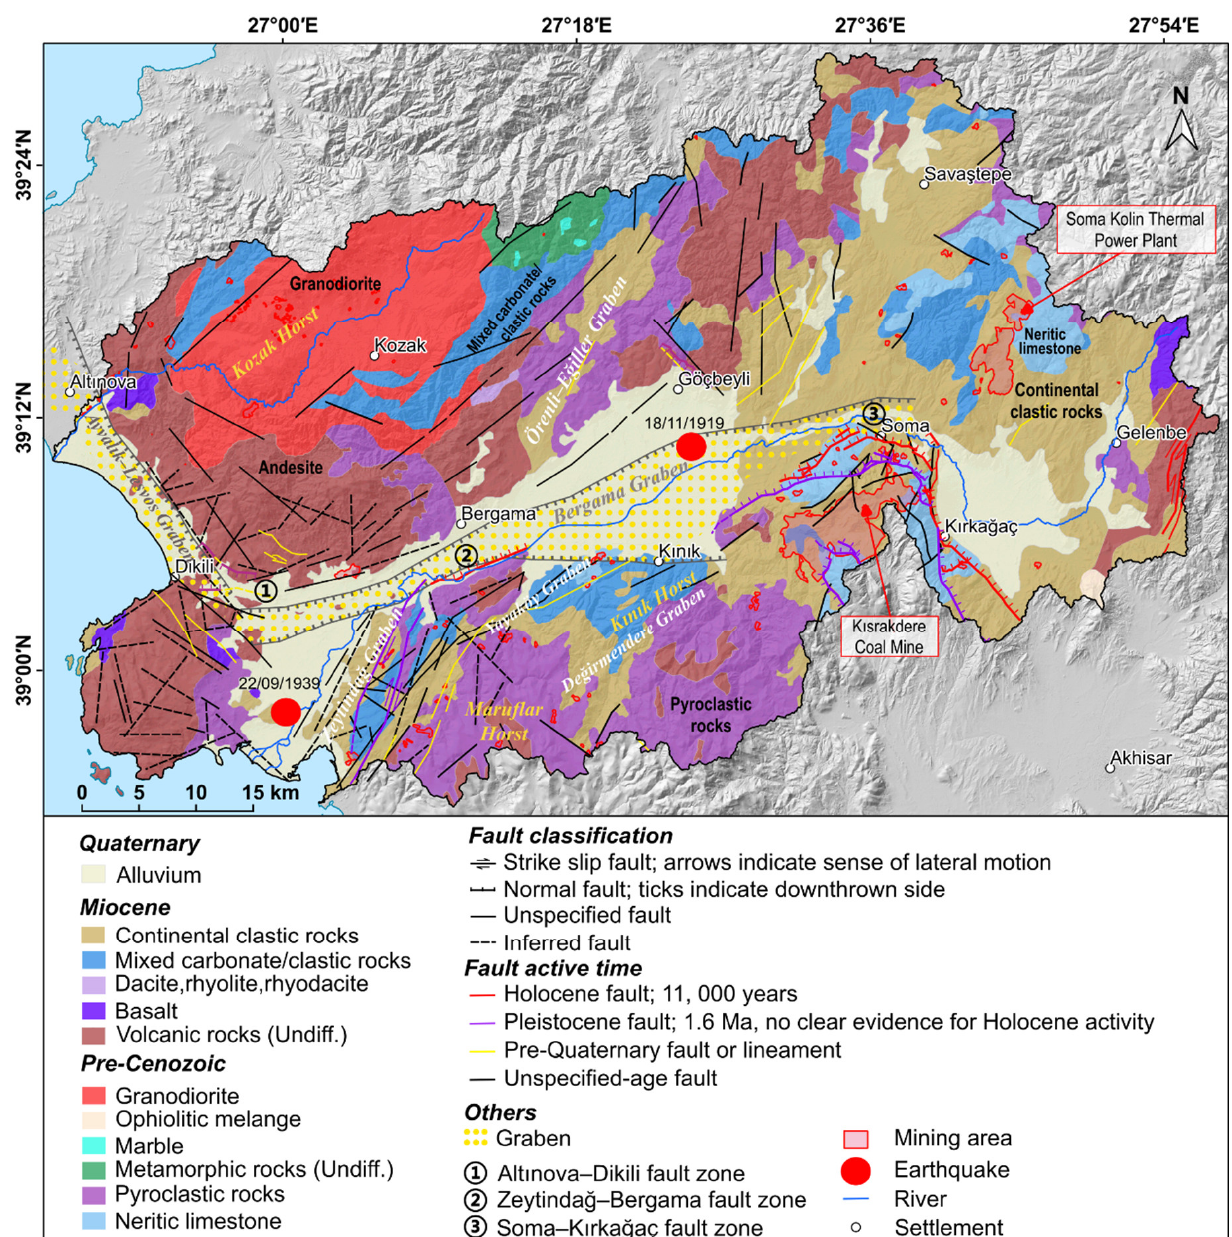
Figure 2. Geological map of the Bakırçay and Madra River catchments and their adjacent coastal areas. Data: (1) bedrock: Geological Map of Turkey, 1:500,000 (İzmir) [60]; (2) fault: 1:250,000 scale Turkey Active Fault Maps [69–72] and the unspecified-age fault (black line) [45,60,73]; (3) location of graben, horst, and fault zones [45]; (4) mining area: Google Earth satellite images (WorldView-2, last accessed 8 June 2020); (5) earthquake epicenter of M ≥ 6.5 since 1900 [68].